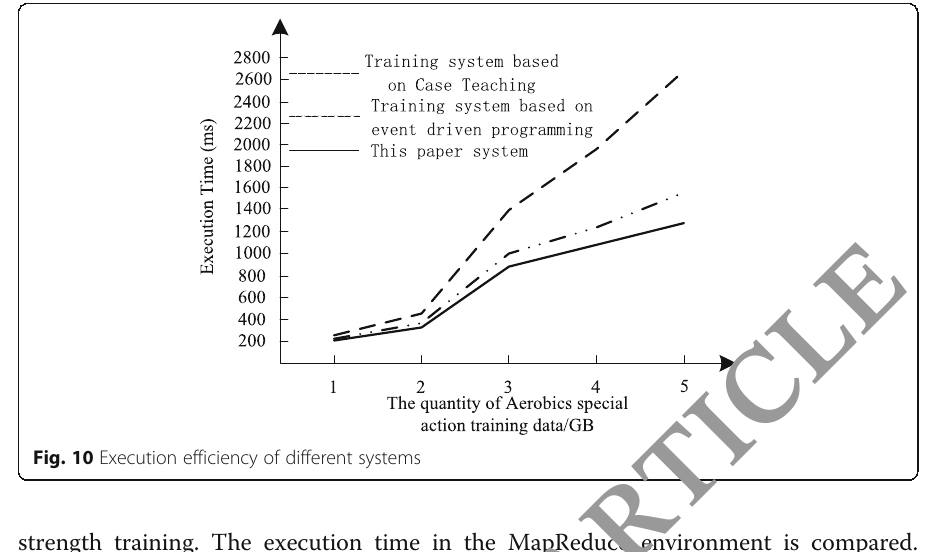
Fig. 10 Execution efficiency of different systems